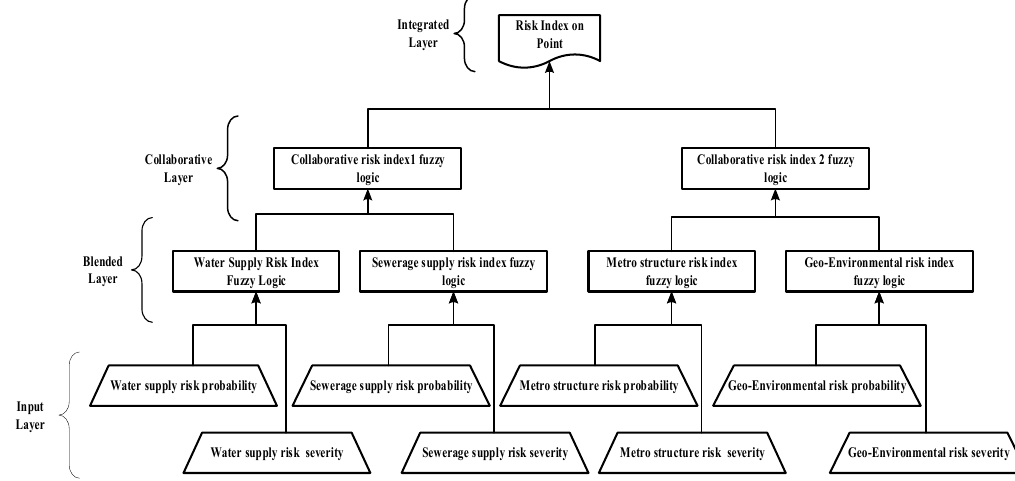
Figure 1. An integrated risk index model based on hierarchical fuzzy logic for underground risk assessment.